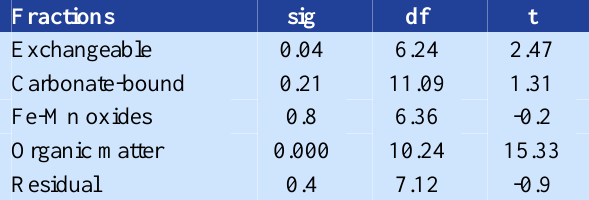
Table 8. Statistical test results for Zn in each fraction between the contaminated soil with Actinidia deliciosa and the control soil Fractions sig